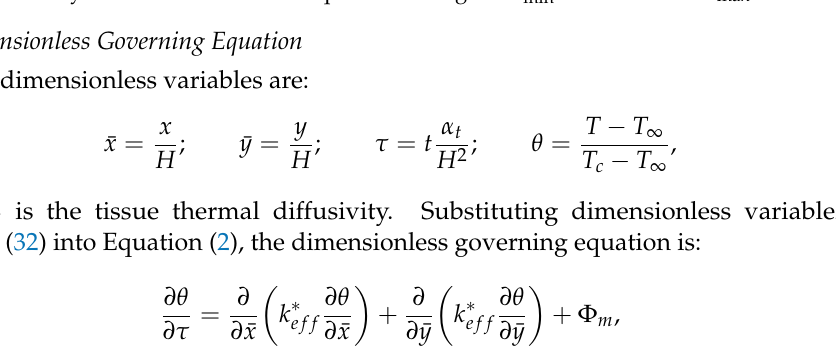
Figure 6. Two-dimensional pore size distribution for ( a ) one-layer tissue with φ = 0.1, ( b ) three-layer tissue with φ = 0,0.5, and 0.05 for epidermis, dermis, and hypodermis, respectively. ( c , d ) The simu- lated pore sizes by the Monte-Carlo technique in the range of λ min = 5 × 10 − 6 to λ max = 5 × 10 − 4